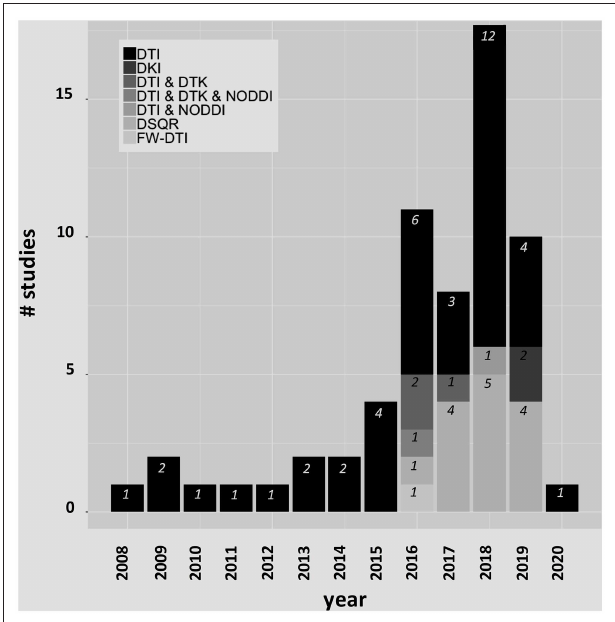
FIGURE 2 | Histograms for the publication years and dMRI techniques included in this